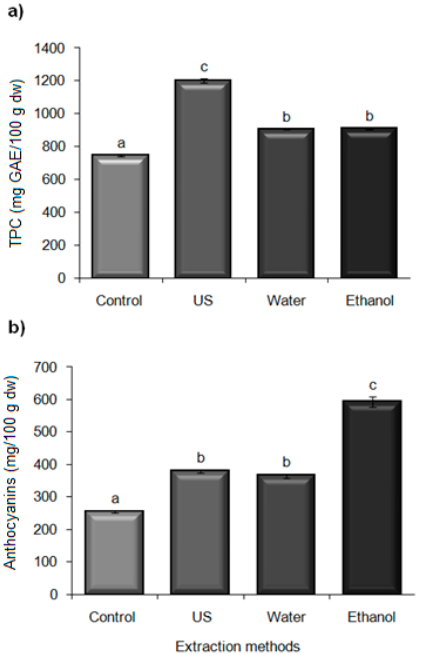
Figure 4. Extraction methods of ( a ) total phenolic content (mg gallic acid equivalent/100 g dry weight basis), and ( b ) anthocyanins (mg cyanidin-3-glucoside/100 g dry weight basis) from blackberry residues. US: ultrasonic extraction (91% amplitude by 15 min), Water: aqueous extraction, Ethanol: ethanolic extraction. a–c Different letters indicate a significant difference ( p < 0.05) between methods.